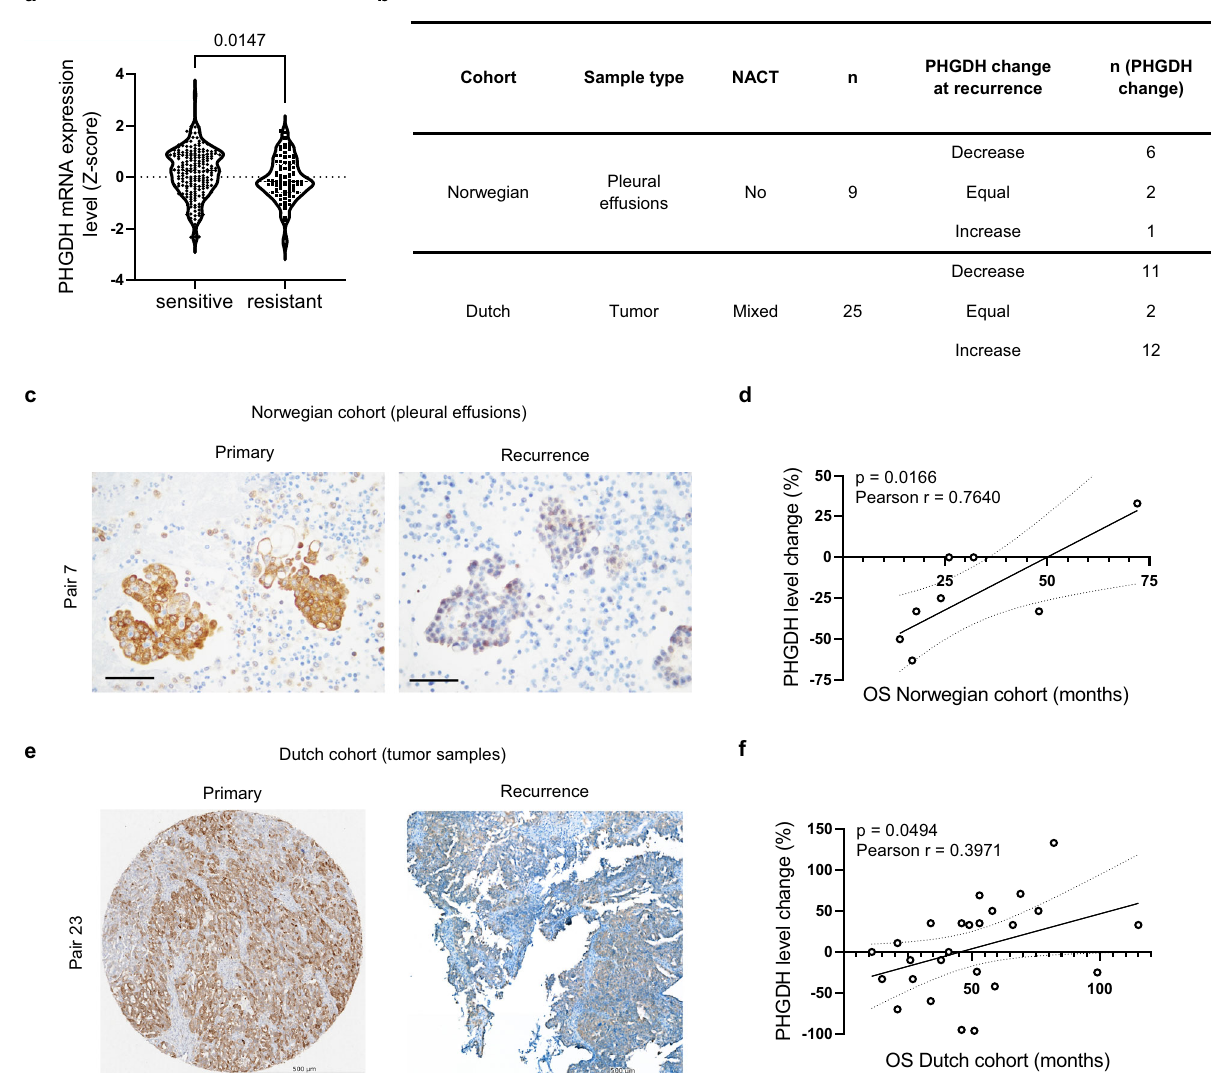
Fig. 1 | Decrease in PHGDH expression after platinum-based chemotherapy identi fi es a subset of ovarian cancer recurrences. a PHGDH mRNA expression levelsofovariancancerpatientsinthe TCGAcohort, n =197 sensitivepatientsand n =90 resistant patients, unpaired two-tailed t -test. b Overview of the Norwegian and Dutch patient cohort and related PHGDH changes, NACT neoadjuvant che- motherapy. c ExampleofPHGDHIHCstainingofprimaryandlaterecurrentclinical specimen of the Norwegian cohort, scale bar is 50 µ m. d Correlation of PHGDH protein level change at recurrence and overall survival in the Norwegian cohort,